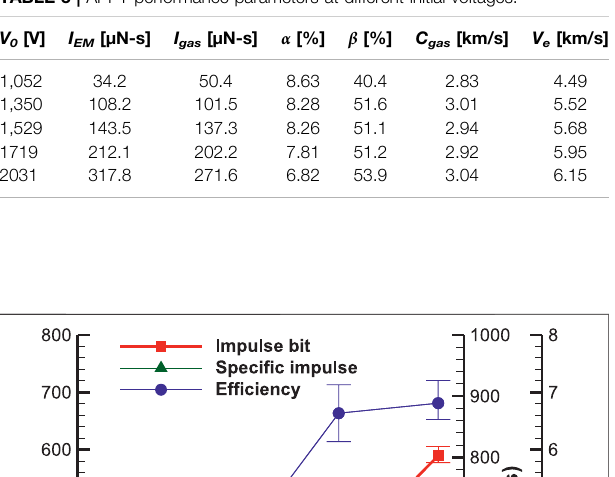
TABLE 3 | APPT performance parameters at different initial voltages.